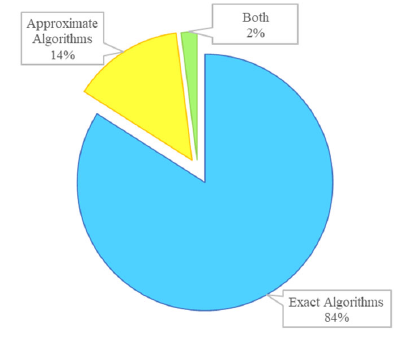
Solution Techniques Parameters Approximate Algorithm Exact Algorithm Heuristic Meta Heuristic